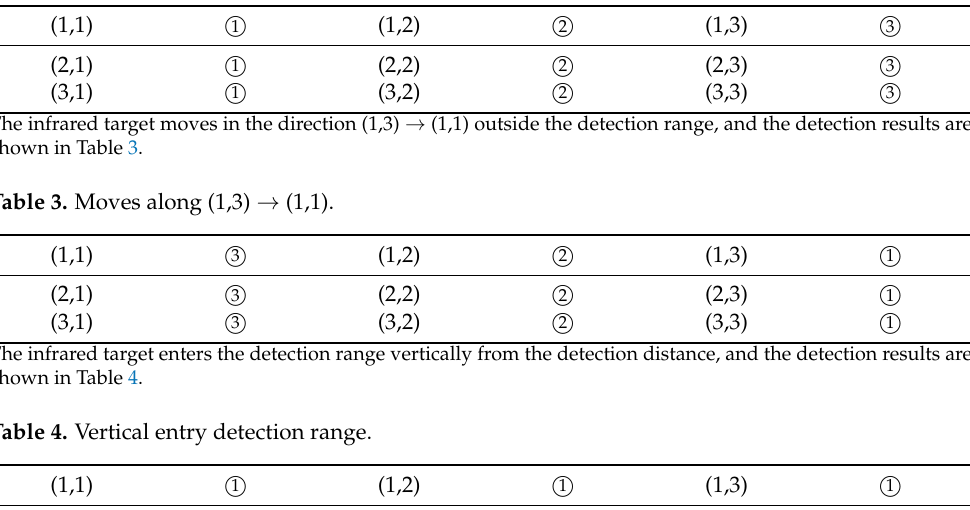
Table 2. Moves along (1,1) → (1,3).